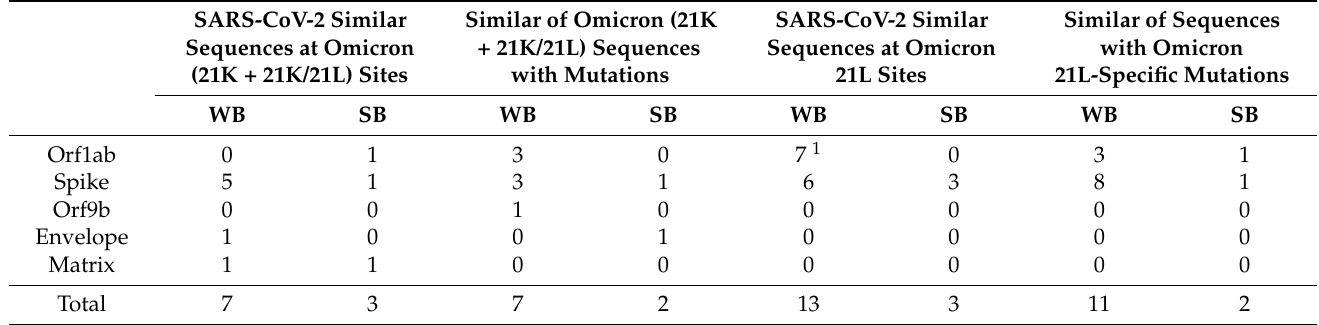
Table 4. The number of WB/SB/E predictions of human proteins (i.e., similar) sharing 6mer with SARS-CoV-2 or Omicron (21K and 21L) at mutation sites and having affinity to the same HLA allele. The first 4 data-columns exclude the relevant data of the Omicron 21L-specific mutation sites. The last 4 columns are the relevant data of the Omicron 21L-specific mutation